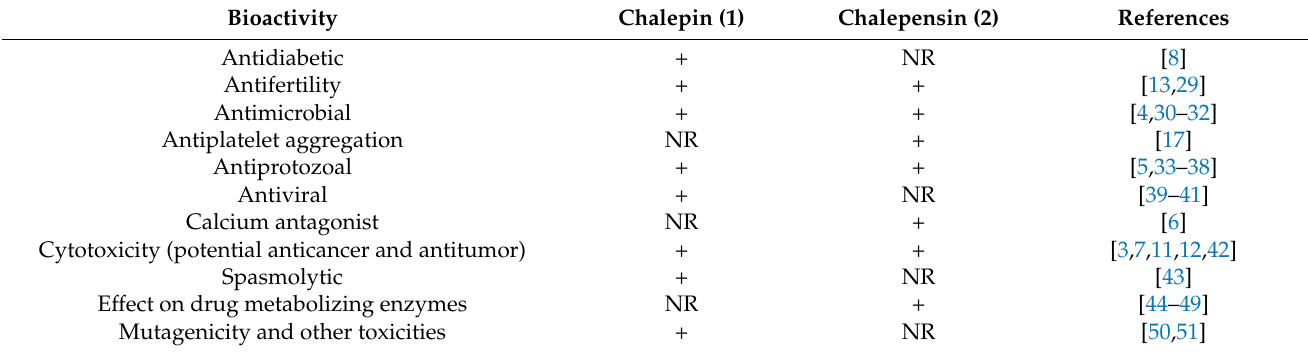
Table 2. Reported bioactivities of chalepin ( 1 ) and chalepensin ( 2